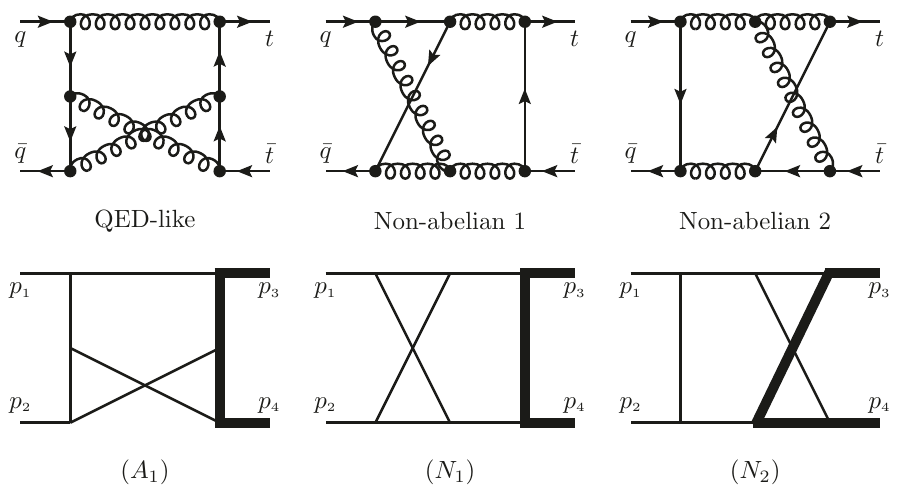
Figure 1. Representative non-planar diagrams contributing at two-loops to q ( p t ( p 3 )+(cid:22) t ( p 4 ) (top row), and the associated integral families (bottom row). Massive propagators and external legs are depicted using thick lines. The diagrams have been drawn with axodraw2